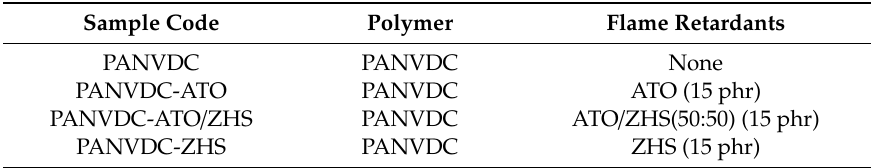
Table 2. Experimental samples with flame